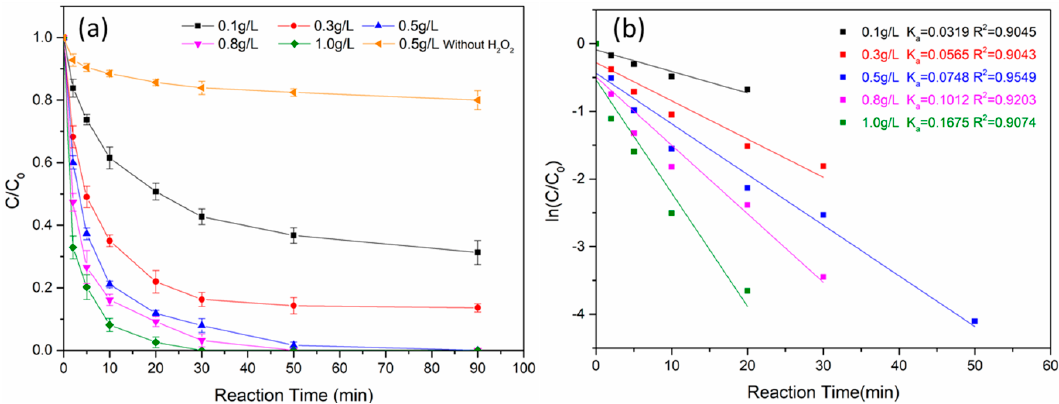
Figure 6. ( a ) Effect of catalyst dosage on 2,4-D degradation. ( b ) Dynamic simulation of 2,4-D Figure 6. ( a ) E ff ect of catalyst dosage on 2,4-D degradation. ( b ) Dynamic simulation of 2,4-D degradation degradation under different catalyst dosages ([2,4-D] 0 = 5.0 mg/L, H 2 O 2 = 1 mM, pH = 5.0 ± 0.2, under di ff erent catalyst dosages ([2,4-D] 0 = 5.0 mg / L, H 2 O 2 = 1 mM, pH = 5.0 ± 0.2, T = 30 ◦ T = 30 °C).